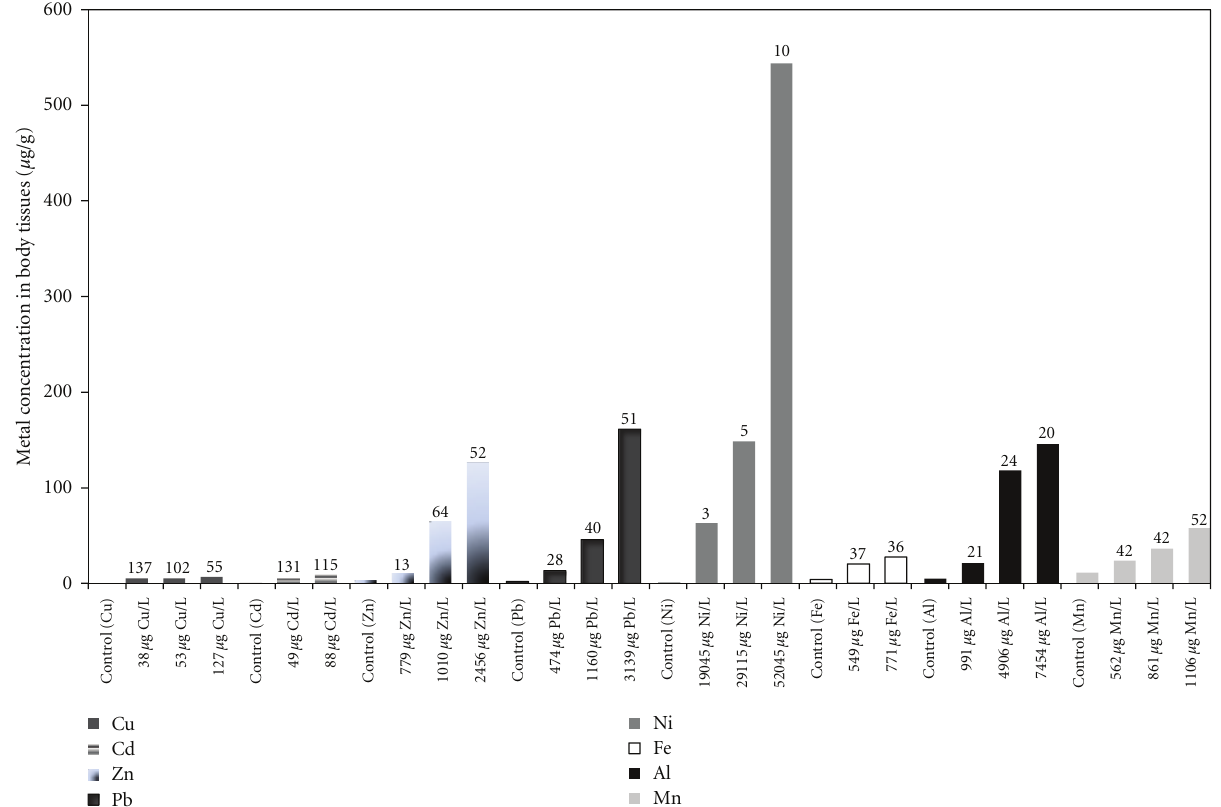
Figure 3: Bioconcentration of Cu, Cd, Zn, Pb, Ni, Fe, Al, and Mn (mean) in S. major after a four-day exposure to di ff erent concentrations of Cu, Cd, Zn, Pb, Ni, Fe, Al, and Mn. Concentration factor (CF) is indicated at the top of each